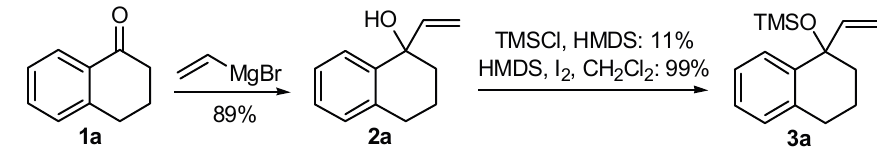
Scheme 1. Preparation of the unsaturated TMS ether 3a . HMDS: hexamethyldisilazane and TMSCl: trimethylsilylchloride.